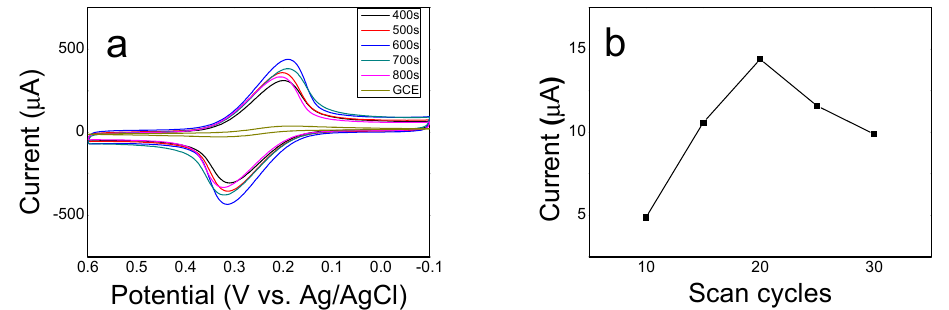
Figure 6. ( a ) CV curves of ERGO/GCE modified electrodes obtained with different deposition time in 0.1 M KCl containing 5 mM K 3 [Fe(CN)] 6 solution, ( b ) Effect of the scanning cycles in electropolymerization process on the SWASV response of 10 ng/mL Cd(II) at a imprinted Cd(II)-IIP /ERGO/GCE.